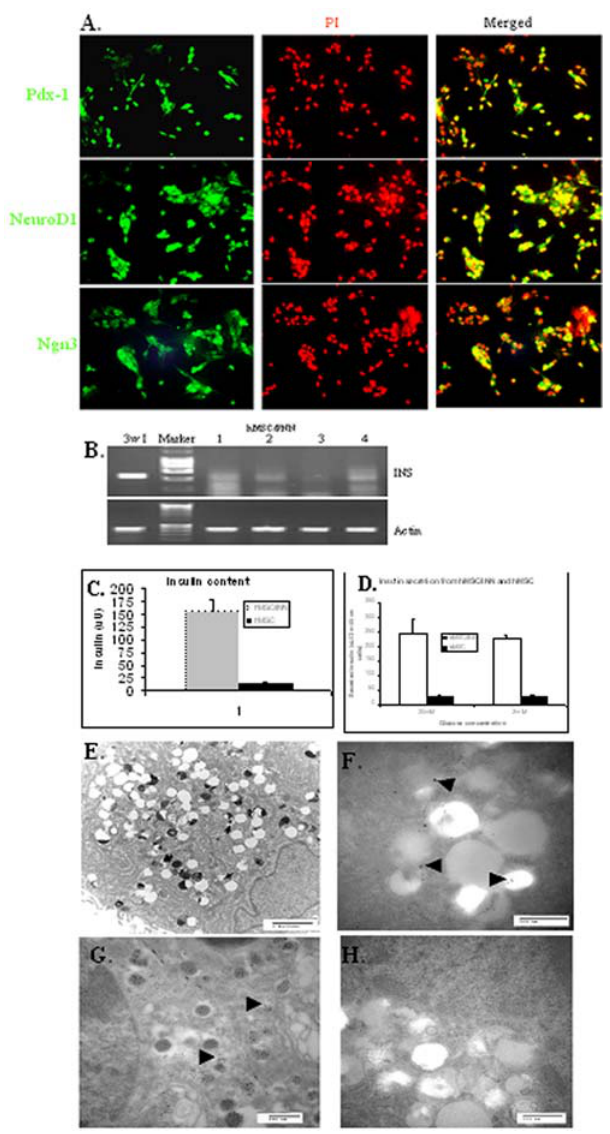
Figure 2. Human MSCs expressed insulin in vitro following differentiation induction. Panel 2a shows the expression of Pdx-1, NeuroD1 and Ngn3 in hMSCs 48 hr post transfection with the 3 genes. Majority of the gene product (green fluorescence) was located in nuclei, but some cells with cytoplasmic expression in all the 3 genes. Panel 2b shows the mRNA of preproinsulin in hMSC/PNNs following 6 days’ differentiation induction in vitro, assessed by RT-PCR. The lanes 1–4 show the typical 4 different RT-PCR experiments on the expression of insulin in hMSC/PNNs, lane 3M shows the expression of insulin in human islet cells after 3 week in monolayer culture. Panel 2c shows the presence of insulin protein content in hMSC/PNNs following differen- tiation induction following correction with protein concentration. Panel 2d shows the insulin secretion by hMSCs and hMSC/PNNs following glucose challenge in a static incubation assay. Panel 2e shows the presence of insulin secretory granules in the hMSC/PNNs in a typical electronic microscopy picture and the magnification indicator is 2 microns. The typical insulin secretory granules are arrowed. Panel 2f shows the presence of insulin protein in hMSC/PNNs, as assessed by immunogold labelling experiments. Panel 2g shows the insulin protein in human islets, served as positive control of 2f, while 2h is the negative control of 2f, in which hMSC/PNNs were stained with non-insulin related IgG1 antibody. The black dots are the gold particles that labelled insulin protein. The magnification indicators in panel 2f–2h are 500 nm. All experiments were repeated at least 3